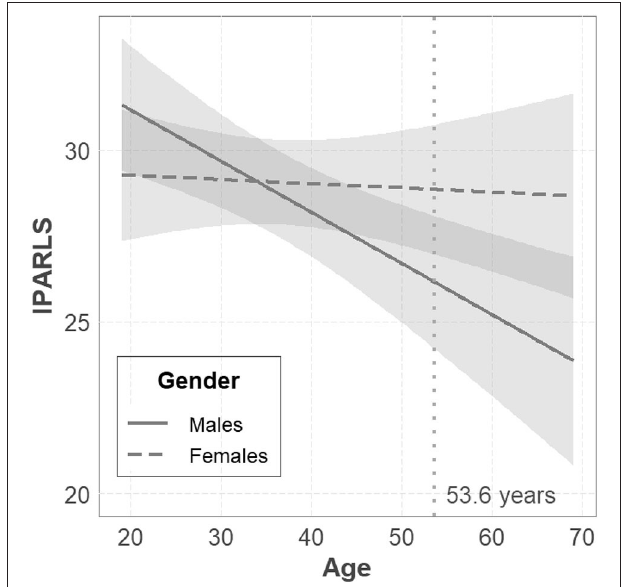
FIGURE 1 | Moderation effect of gender on the relation between age and loneliness (IPARLS). Bandwidth indicates a confidence interval of 95%.